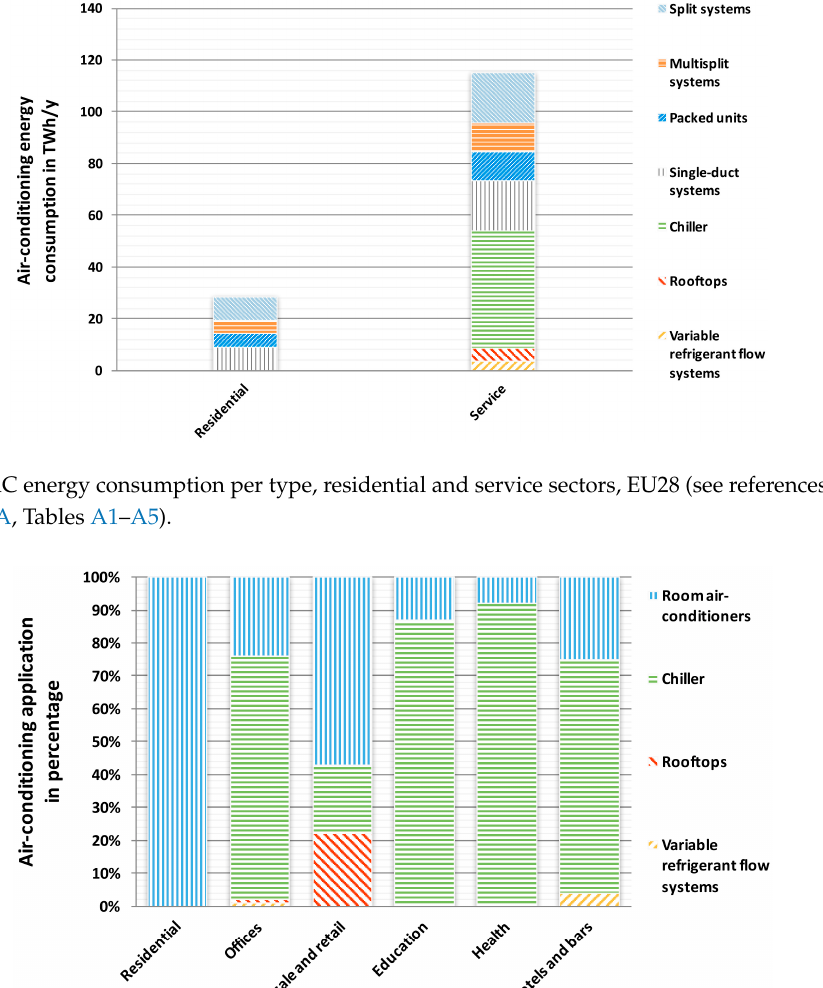
Figure 4. Distribution of installed AC application by sector and type, EU15 [13,43,44].